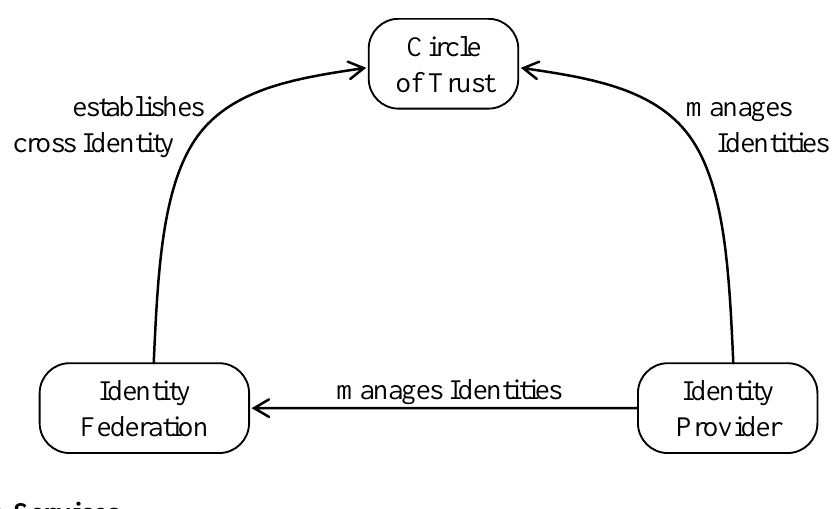
Figure 3. Relationships between identity